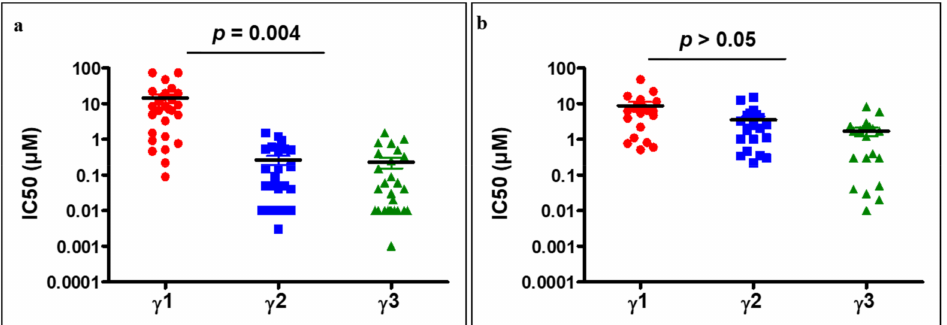
Figure 4. Comparing the distribution of IC50 values of kinase inhibitor-1 ( γ 1), kinase inhibitor-2 ( γ 2), and their equimolar combination ( γ 3) across all cell lines exhibiting a fold difference in IC50 of ( a ) > 6 and ( b ) ≤ 6. Note that γ 1 > γ 2 and κ represents the fold difference, which is calculated as γ 1/ γ 2. Statistical analysis was carried out using unpaired two-tailed Student t